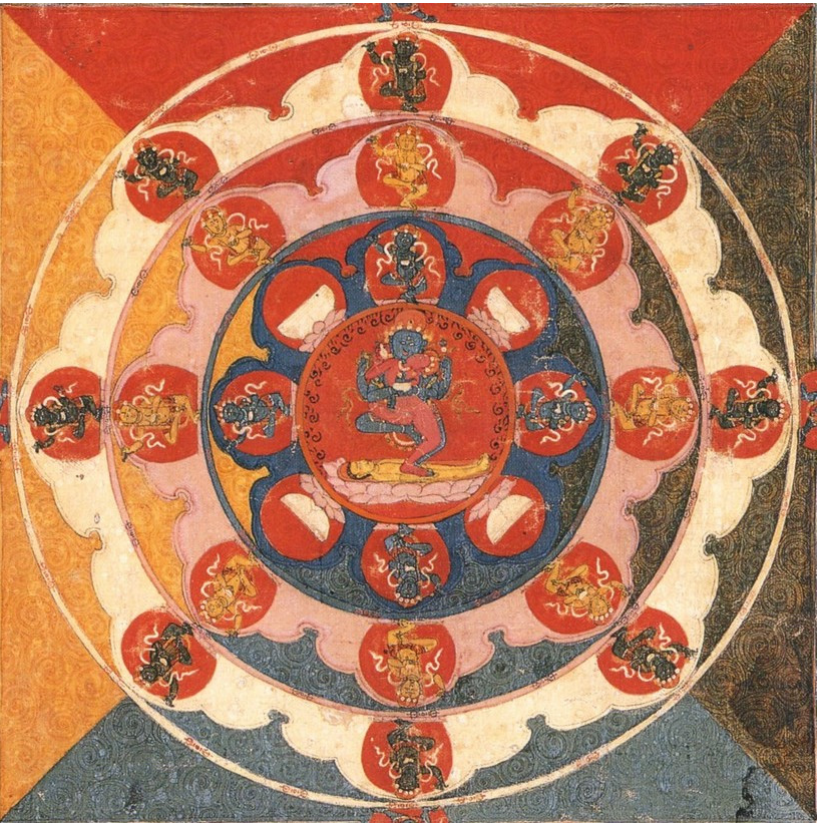
Figure 3. Buddhakap ā la surrounded by yogin ī s within a ma ṇḍ ala . (Himalayan Art Resource, Item Figure 3. Buddhakap¯ala surrounded by yogin¯ı s within a man. d. ala . (Himalayan Art Resource, Item 88556).